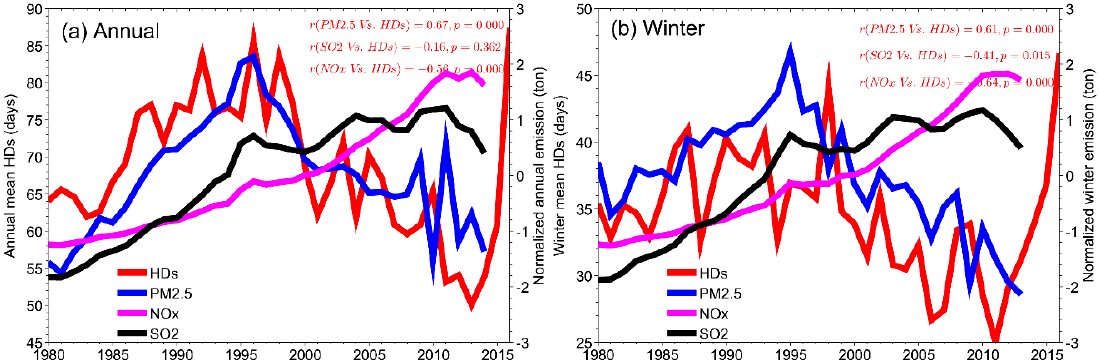
Figure 10. The time series of observed HDs (red line) and normalized anthropogenic emissions of PM 2.5 (blue line), NOx (magenta line), and SO 2 (black line) for annual ( a ) and winter ( b ) averaged over SCB from 1980 to 2014. The correlation coefficients between HDs and emissions for 1980–2014 are also given in the top panels.